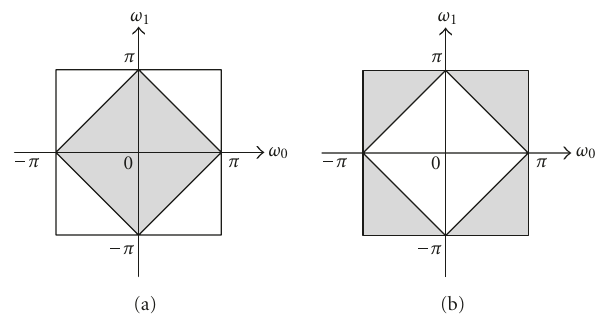
Figure 5: Ideal frequency responses of quincunx filter banks for the (a) lowpass filters and (b) highpass filters, where the shaded and unshaded areas represent the passband and stopband, respectively. Figure 6: Weighting function for a highpass filter with diamond- shaped